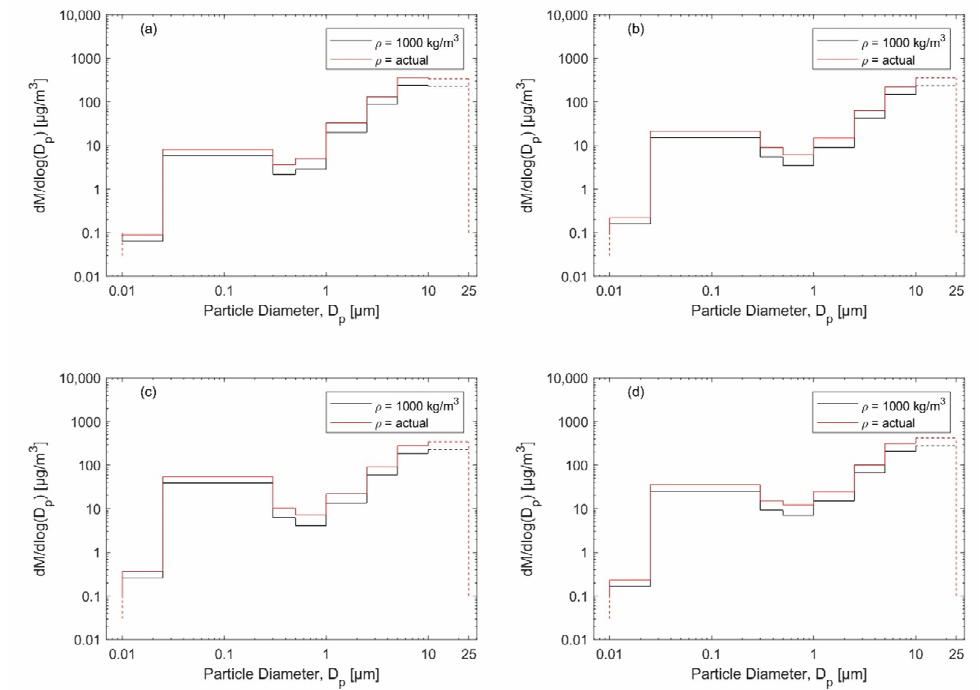
Figure 3. Particle mass size distributions calculated from the measured particle number size distributions (Figure 2): ( a ) rural background—outside the populated areas in the city, ( b ) urban background—University of Jordan campus and nearby areas, ( c ) main roads—tra ffi c, and ( d ) city center—urban. The black curves were determined by assuming spherical particles of unit density, whereas the red curves were based on e ff ective densities in urban background conditions in Asian cities according to a review by Wu and Boor [53], (Table 2). Table 2. Urban aerosol e ff ective densities for Asian cities according to review by Wu and Boor [53]. Range of D p [ µ